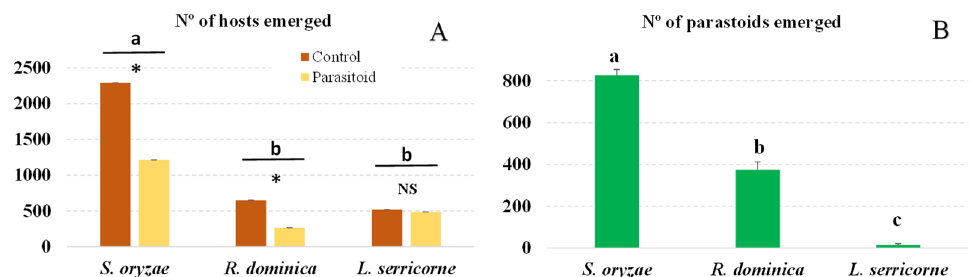
Figure 1. Number (mean + SEM) of emerged host progeny ( A ) and of A. calandrae adults that developed in each host species ( B ). Bars for each host headed by a different letter and bars within each host headed by an asterisk are significantly different ( p < 0.05, Tukey test), NS indecates no significant difference. Table 1. Percentage (mean ± SEM) of host mortality, parasitism and PIM (host feeding, unsuccessful parasitism) caused by A. calandrae when the larvae of S. oryzae , R. dominica or L. serricorne were offered. Mean ( ± SEM) hind tibia and body length of A. calandrae (males and females) emerging from each host species. N = 40 (20 males and 20 females). In each row, means followed by a different letter are significantly different ( p < 0.05, Tukey). Body size measurements are given in mm.